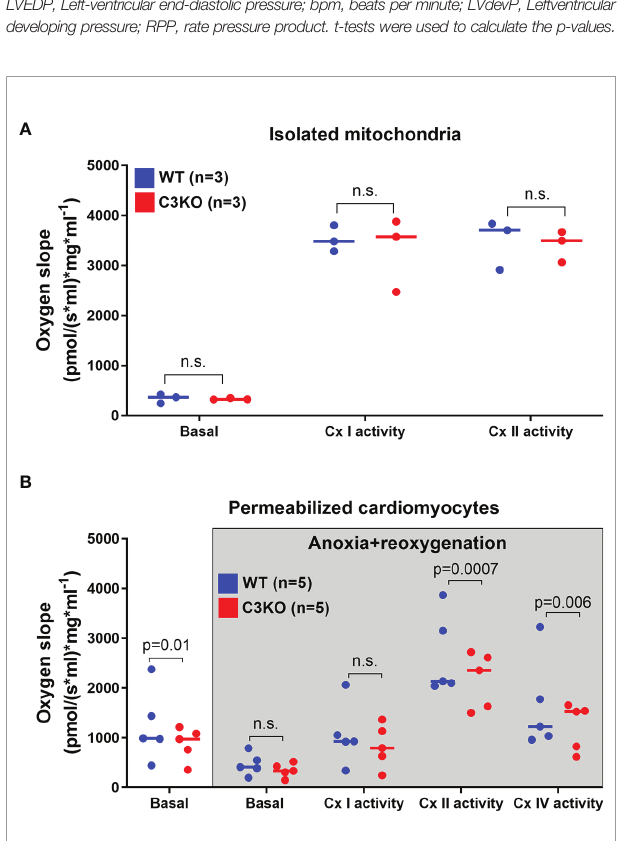
FIGURE 3 | Mitochondrial respiration in WT and C3KO cardiomyocytes. Mitochondrial respiration (oxygen slope) was measured in (A) isolated mitochondria from hearts of wild type (WT) and mice with knock out of complement component 3 (C3KO) exposed to different substrates and mitochondrial complex inhibitors with high-resolution respirometry (Oroboros Oxygraph-2k). (B) Oxygen consumption was also measured in permeabilized cardiomyocytes that underwent anoxia for 35 minutes, similar as Langendorff experiment ( Figure 2 ), with subsequent 10 minutes of reoxygenation. Data sets are displayed as scatterplots with median. ns, not signi fi